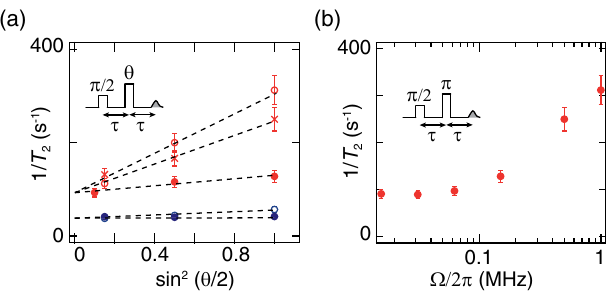
FIG. 3. Instantaneous diffusion in Res1. (a) Measured echo amplitude decay rate T − 1 2 as a function of sin 2 ð θ = 2 Þ , with θ being the Rabi angle achieved during the refocusing pulse, for the first transition (red symbols) and the fourth transition (blue symbols). Solid circles, crosses, and open circles are data for refocusing pulse bandwidths of 150 kHz ( κ = 2 π ), 500 kHz, and 1 MHz, respectively. Dashed lines are linear fits to the data. (b) Decay rate T − 1 2 of the echo amplitude as a function of the pulse bandwidth Ω , for transition i ¼ 1 , and at a refocusing angle of π . Measurements are done with square pulses of duration 64 μ s, 32 μ s, 16 μ s, and 2 μ s, and shaped pulses of duration 0 . 5 μ s and 1 μ